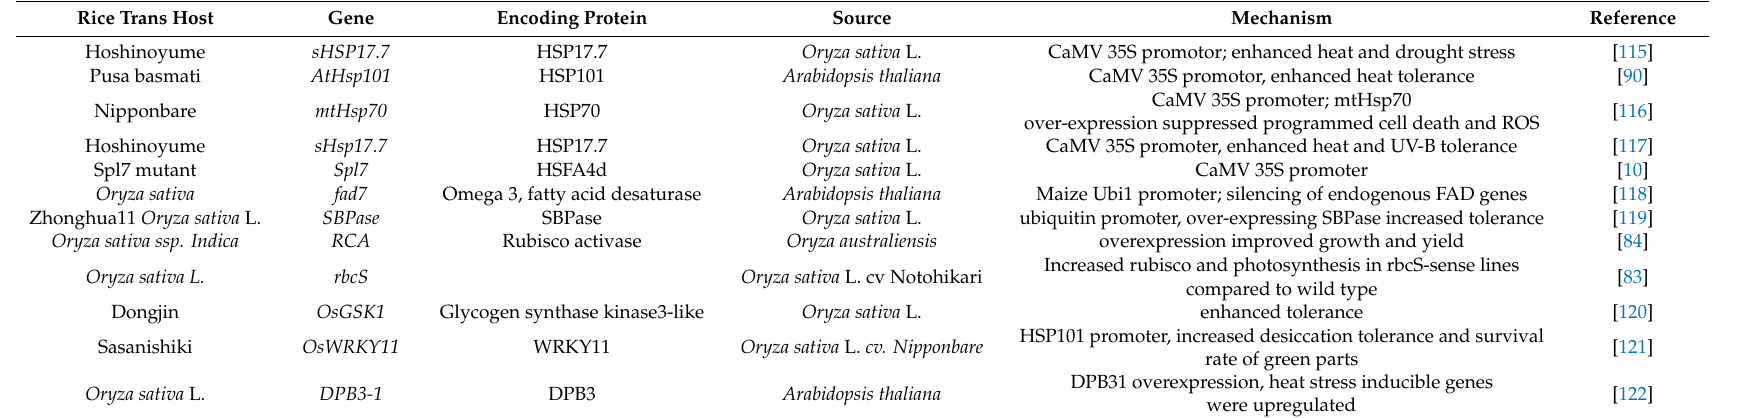
Table 1. Transgenic rice and gene in response to heat